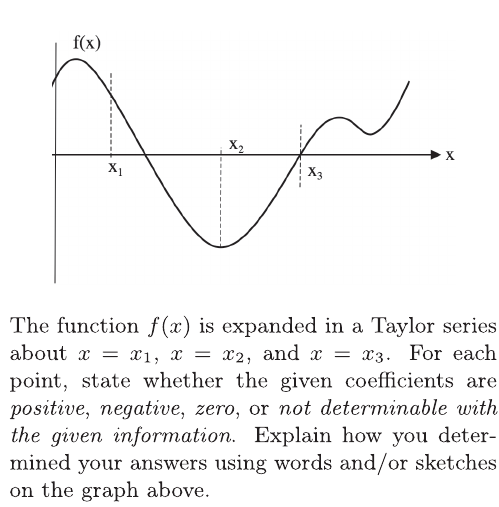
FIG. 1. Taylor series pretest. Students were given equations similar to Eq. (3) for series centered at x 1 , x 2 , and x 3 to show the algebraic meanings of the coefficients a i , b i , and c i .